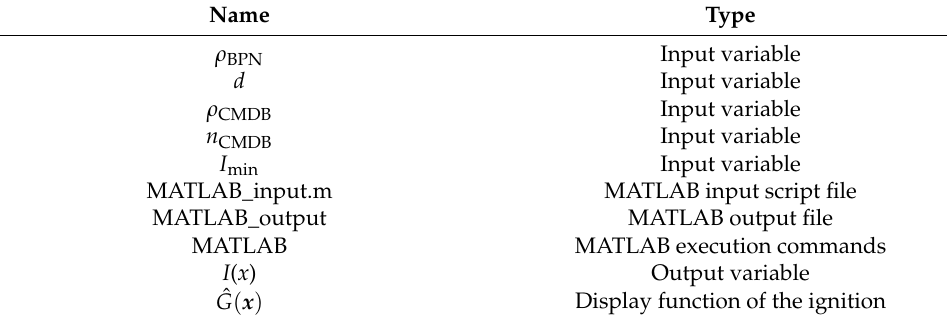
Figure 8. Ignition simulation workflow of the pyrotechnic igniter. Table 4. Nodes in the simulation workflow.